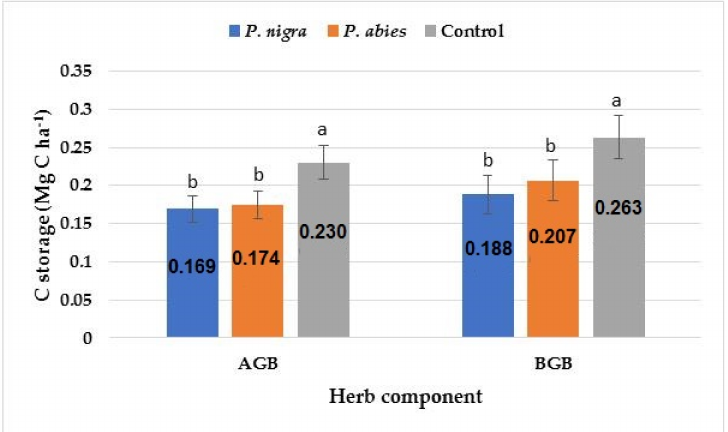
Figure 2. C storage in shrub components at the study sites. Significant differences among the means at different sites are indicated with lowercase letters by Duncan’s test at α = 0.05; the bars indicate the standard error of the estimate.